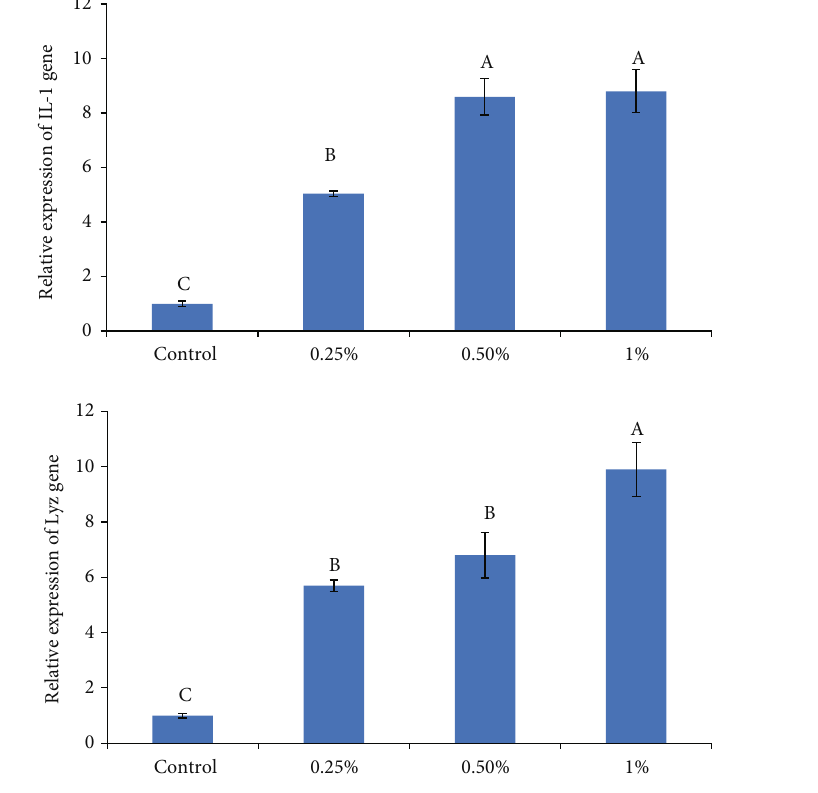
Figure 1: The e ff ects of di ff erent levels of U. intestinalis on immune-related gene expression in the intestine of zebra fi sh ( n = 9 ). Values are presented as the mean ± S : D . The bars assigned with di ff erent letter denote signi fi cant di ff erence between treatments ( P < 0 : 05